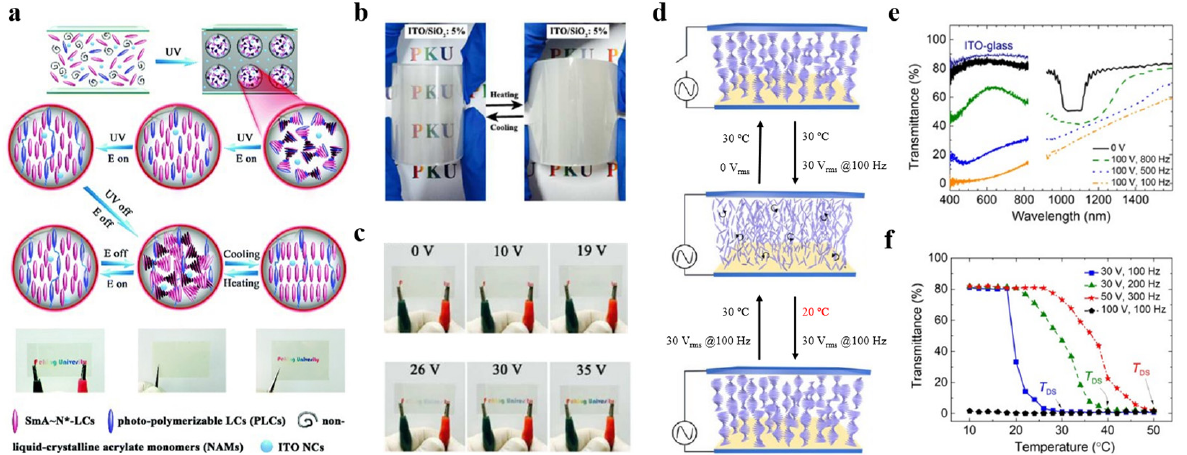
Figure 5. ( a ) Schematic diagram of preparation of PD&SLC film [91]. Digital photographs of flexible PD&SLC film controlled by ( b ) temperature and ( c ) electric field, respectively [91]. ( d ) Schematic explication of TR/ER LC smart window under different driving modes [92]. ( e ) Transmission spectra of smart window driven by 100 V at three different frequencies [92]. ( f ) At different temperatures, transmittance as a function of voltage and frequency [92]. “*” means the chiral LC phase.